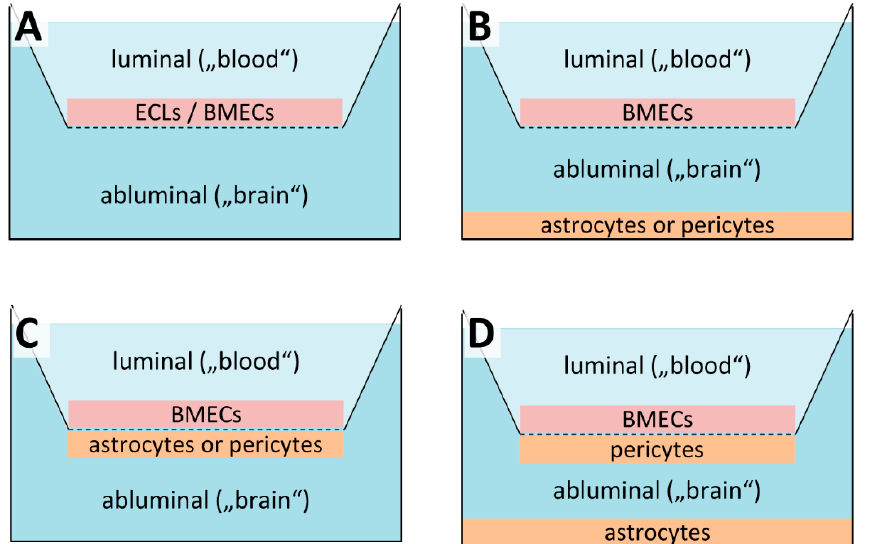
Figure 4. Static in vitro models of the blood-brain-barrier (BBB). ( A ) Simple static models are typically either based non-BBB epithelial cell lines (ECLs) that may be transfected with BBB-specific efflux transporters or on primary/immortalized brain microvascular endothelial cells (BMECs). The cells are grown as a monolayer on microporous, semipermeable membrane-based cell culture inserts that separate a cell culture well into luminal and abluminal compartment for permeability assays. ( B ) For static non-contact co-culture models, astrocytes or, less frequently, pericytes are grown on the bottom of the cell culture well to allow for indirect cell-to-cell communication with the BMECs via secreted soluble factors. ( C ) Static contact co-culture models are similar to non-contact models, except that the second cell type is grown on the underside of the cell culture insert and thus in close proximity of the BMECs. ( D ) For static triple co-culture models, pericytes are grown on the underside of the cell culture insert while astrocytes are grown on the bottom of the culture well in order to more closely resemble the multicellular nature of the BBB in vivo.